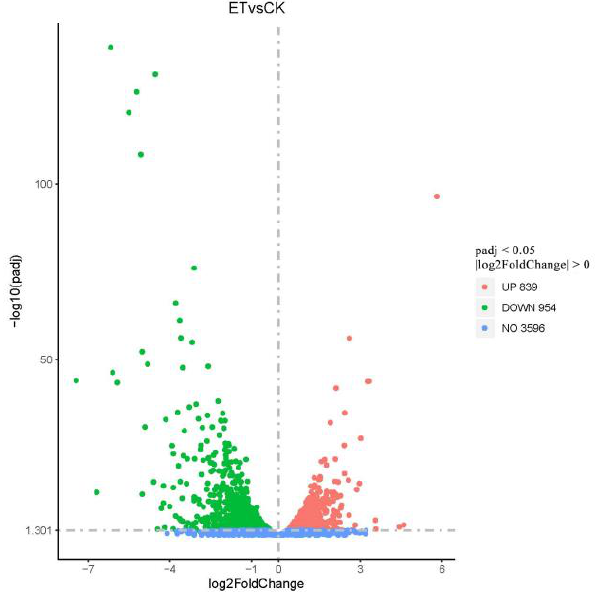
Figure 7. Volcano map of differentially expressed genes. Padj is the p -value after being corrected for multiple testing. The log2FoldChange is based on 2, and then the ratio of the gene expression levels of the treatment group and the control group is taken as the logarithmic value.